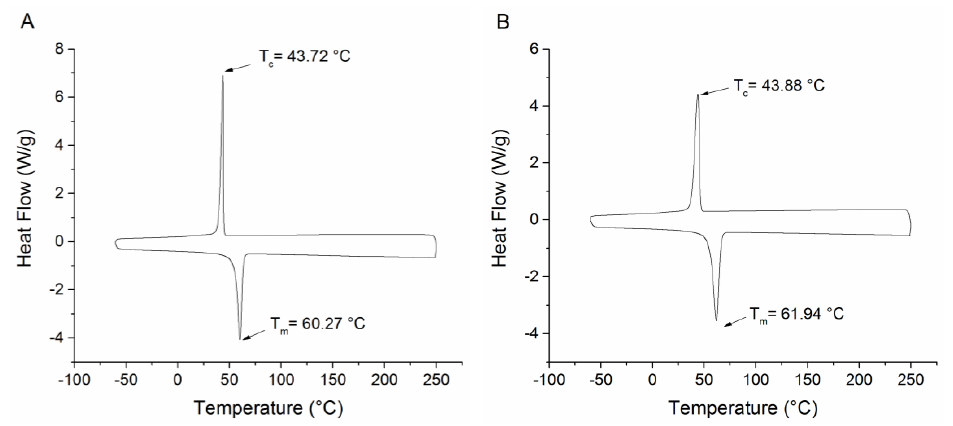
Figure 7. Differential scanning calorimetry (DSC) plot of PEO-PDA fibers: ( A ) blue fibers; and ( B ) red fibers.